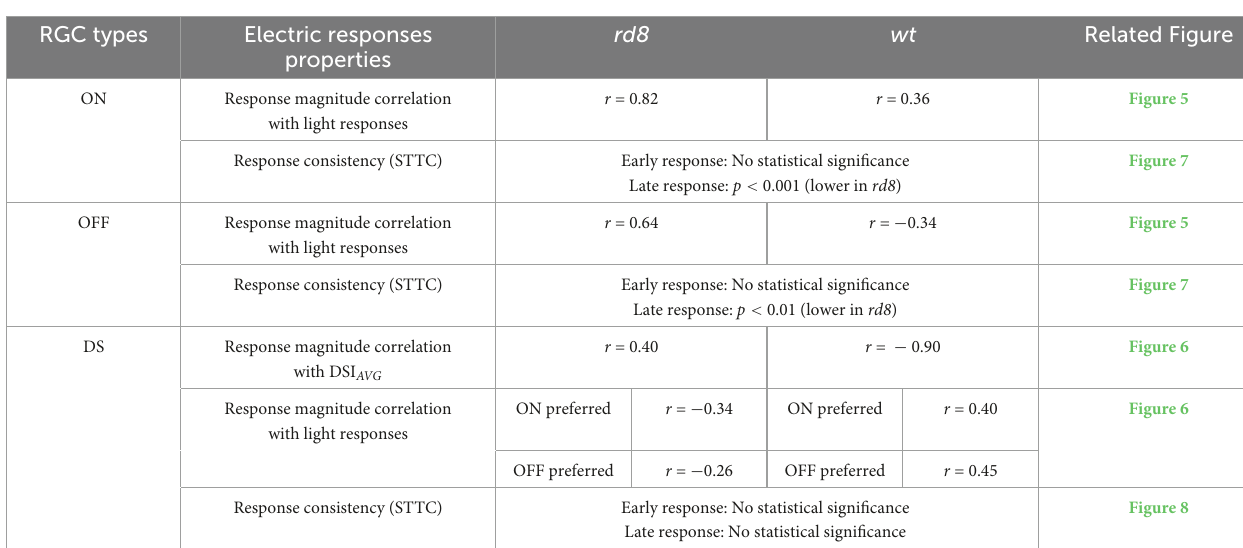
TABLE 2 Summary of populational electric response feature comparisons between rd8 and wild-type ( wt )